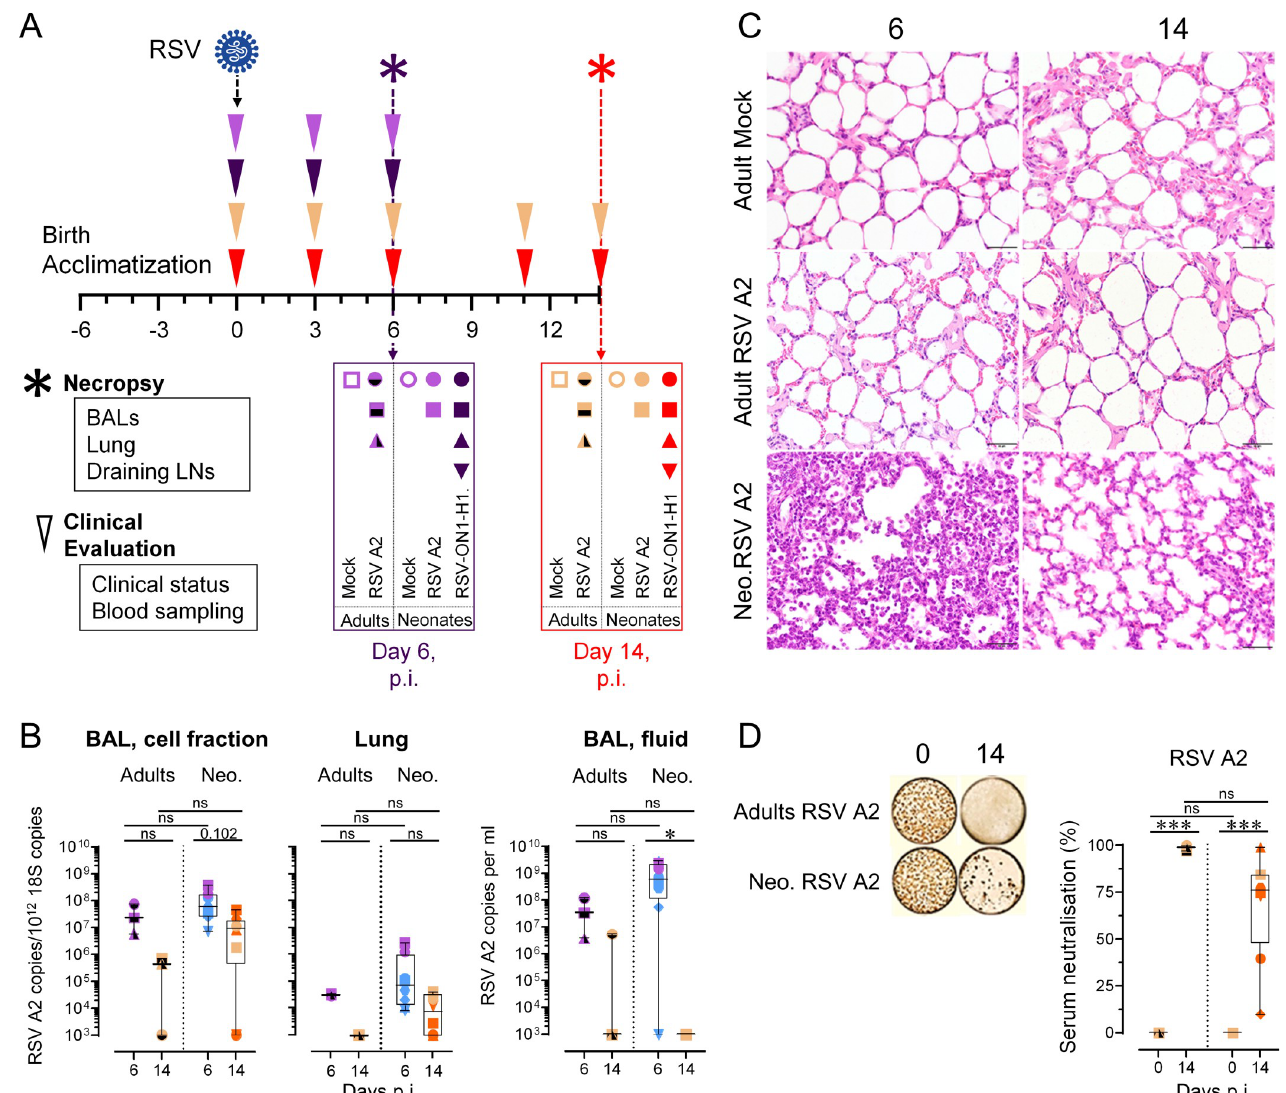
Fig 6. RSV A2-infected adults clear efficiently the virus in absence of lung lesions. (A) Experimental design of the trans-tracheal RSV A2 or RSV-ON1-H1 infections. Animals were injected with 10 8 PFU (RSV A2) or 10 7 PFU (RSV-ON1-H1). As controls, PBS-injected newborns or non-infected adults were used. Before and after RSV infection, clinical evaluation was assessed by a veterinarian, every 3 days. Necropsies were done at days 6 or 14. (B) RSV A2 was quantified in the respiratory tract (BAL, cell fraction; lung; BAL, fluid) of adults and neonates by qPCR. (C) Representative histological lung tissue sections from RSV A2-infected neonates and adults at day 6 and 14 p.i. (40X, HE). Adults show no histological lesions, whereas neonates show interstitial pneumonia at day 6.p.i. (D) Adults and neonates produced RSV A2 NAbs following infection. Serums collected in animals prior RSV A2 infection (0), and at days 14 p.i. (14), were co- incubated with RSV A2 (100 PFU) and applied to HEp-2 cells for 48 hours. (A-D) Each symbol represents an individual animal (RSV A2 infected adults, n = 3; Neonates infected with RSV A2, n = 8 per time point). Boxplots indicate median value (center line) and interquartile ranges (box edges), with whiskers extending to the lowest and the highest values. Groups were compared using one-way ANOVA followed by Turkey’s post hoc test (B, D). Stars indicate significance levels. � , p < 0.05; ��� , p < 0.001. γδ T cell pool in the lower airways. For the CD4 + subset, no significant recruitment was found when compared to related healthy adults (Fig 7H). The percentages of IL-4-producing cells were far from achieving the magnitude observed in neonates, and RSV infection had no con- sistent influence on IFN- γ induction (Fig 7I and 7J). Another clear difference was the contrac- tion of effector memory pool (CD25 + CD45RO + ) at day 14 p.i., indicative of a specific immune